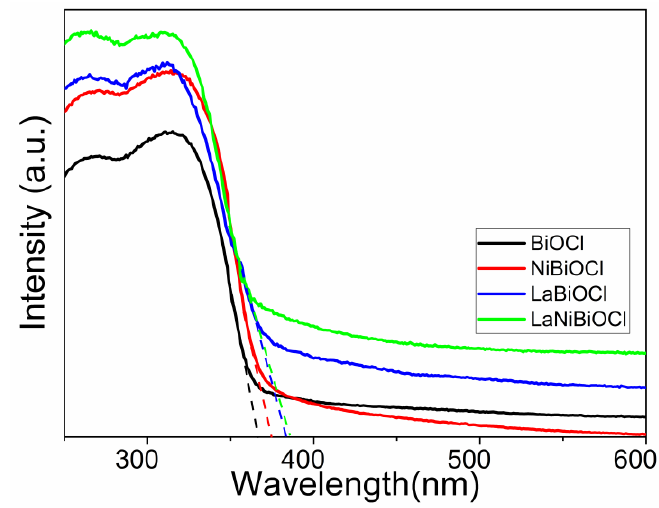
Figure 5. UV-Vis absorption spectra of as-prepared samples.